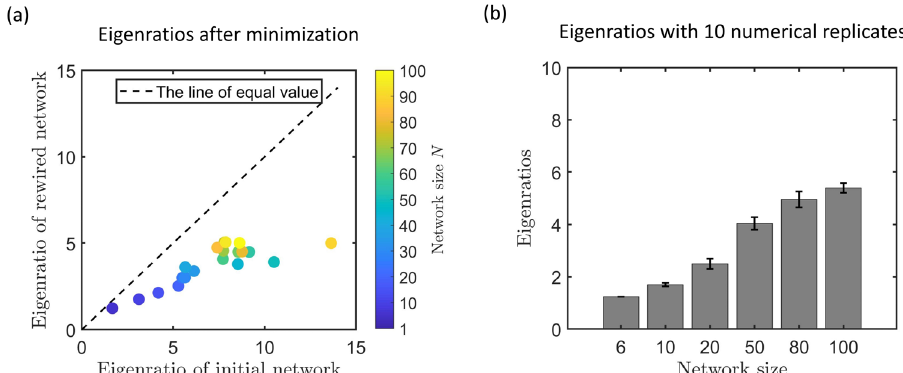
Fig. 3 Eigenratios of networks with 2-hyperlink interactions before and after the optimization on synchronizability. a The eigenratio variation before and after the optimization, which shows that the optimizing procedure decreases eigenratios and enhances synchronizability. The network sizes include 6 and those from 10 to 100 with a step size 5, denoted by color. b The eigenratios of the optimized network with 2-hyperlink interactions for various size 6, 10, 20, 50, 80, 100. The errorbar denotes the standard deviation of 10 numerical replicates, and each replicate is the optimal from 1000 different randomly initialized networks.